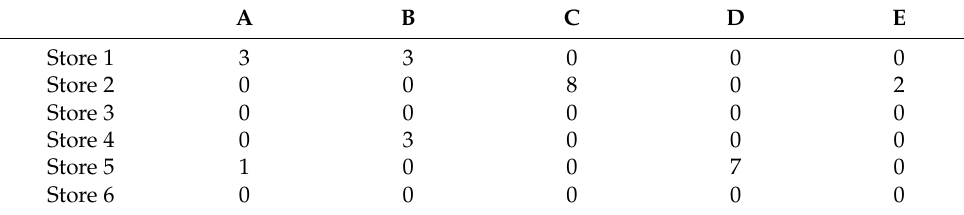
Table 4. Feasible candidate solution.